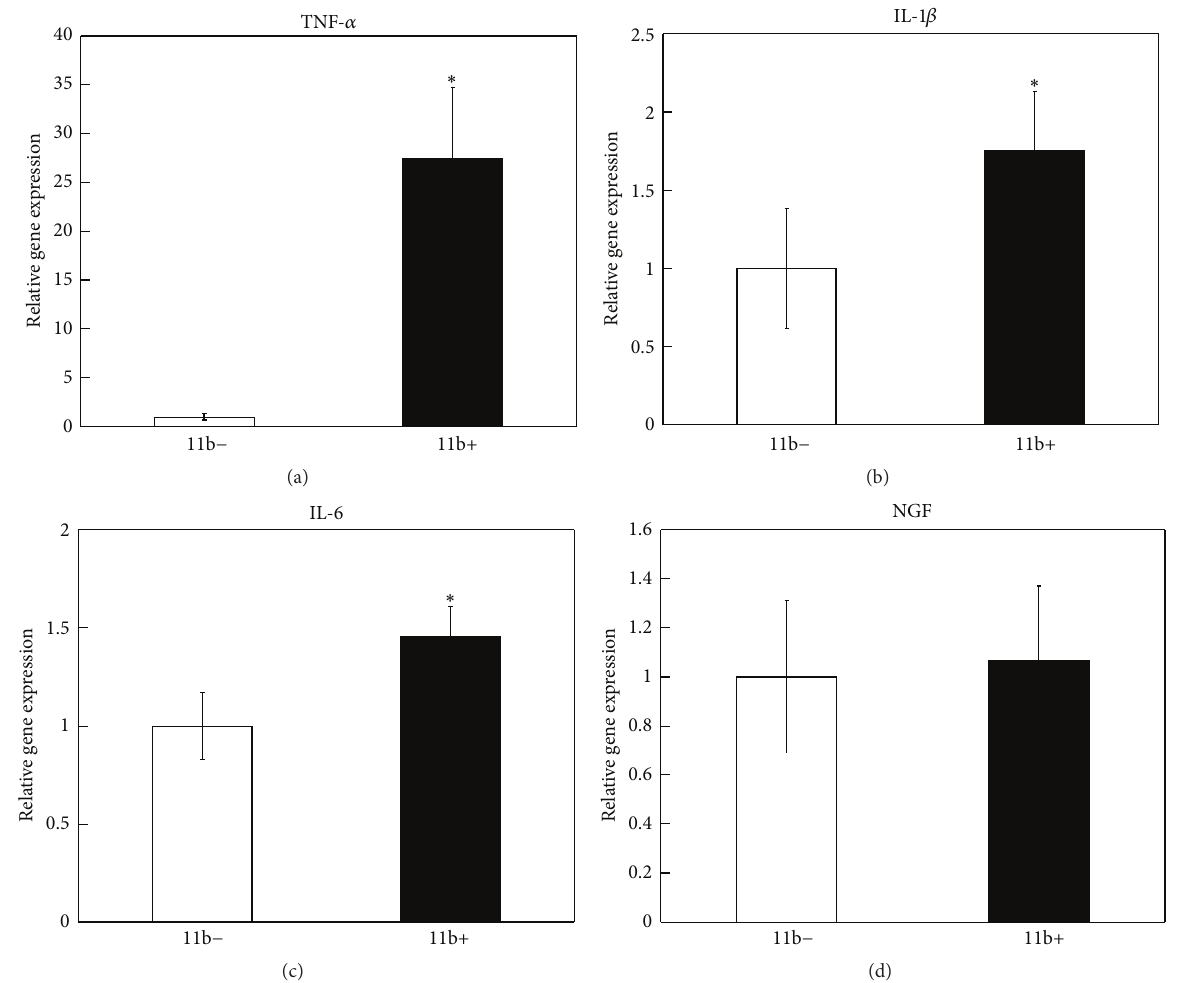
Figure 2: Real-timePCR analysis for the gene expression of TNF- 𝛼 , IL-1 𝛽 ,IL-6, and NGF in CD11b-negative and CD11b-positivecell fractions obtained from synovial tissue of STR/Ort mice. All data are presented as the mean ± SE of four